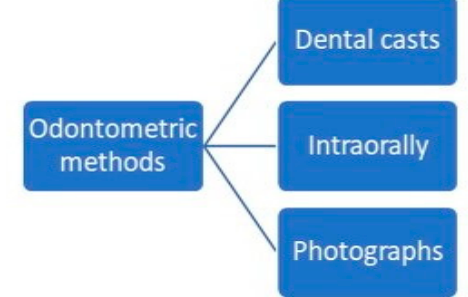
Figure 4. Types of odontometric methods.